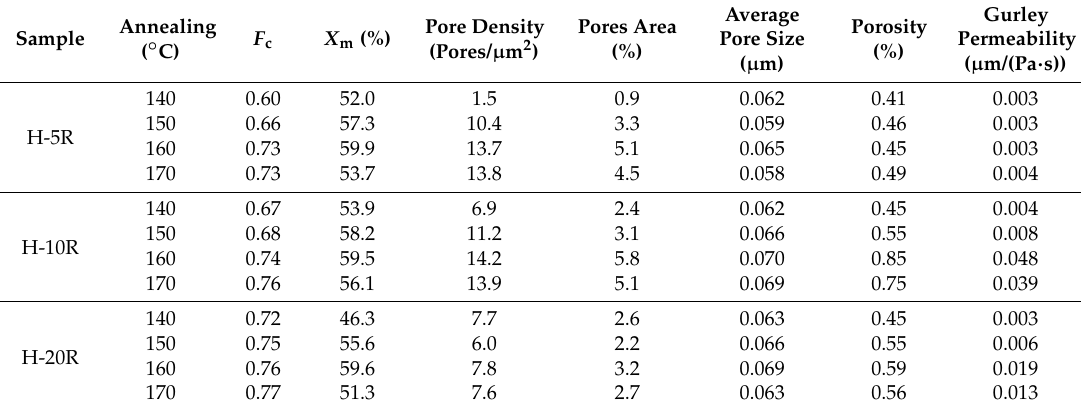
Table 3. Characteristics of membranes prepared with the PP random copolymer under the same stretching temperature (140 ◦ C), differing on blending ratio and annealing temperature.